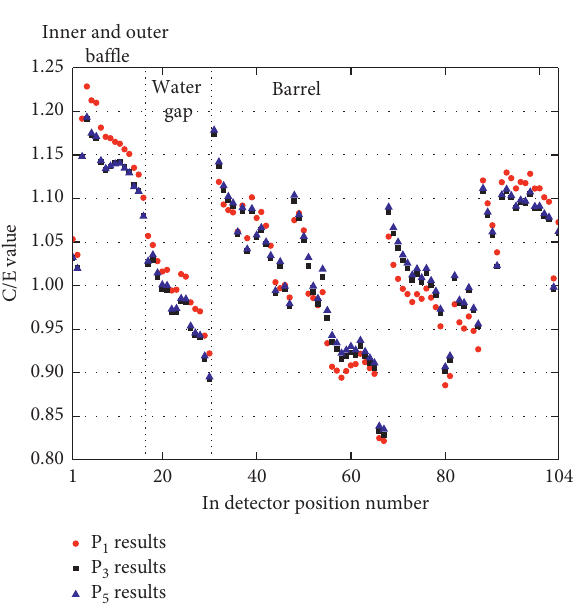
Figure 17: Comparison of P 1 transport correction of the 58 Ni(n,p) 58 Co detector.